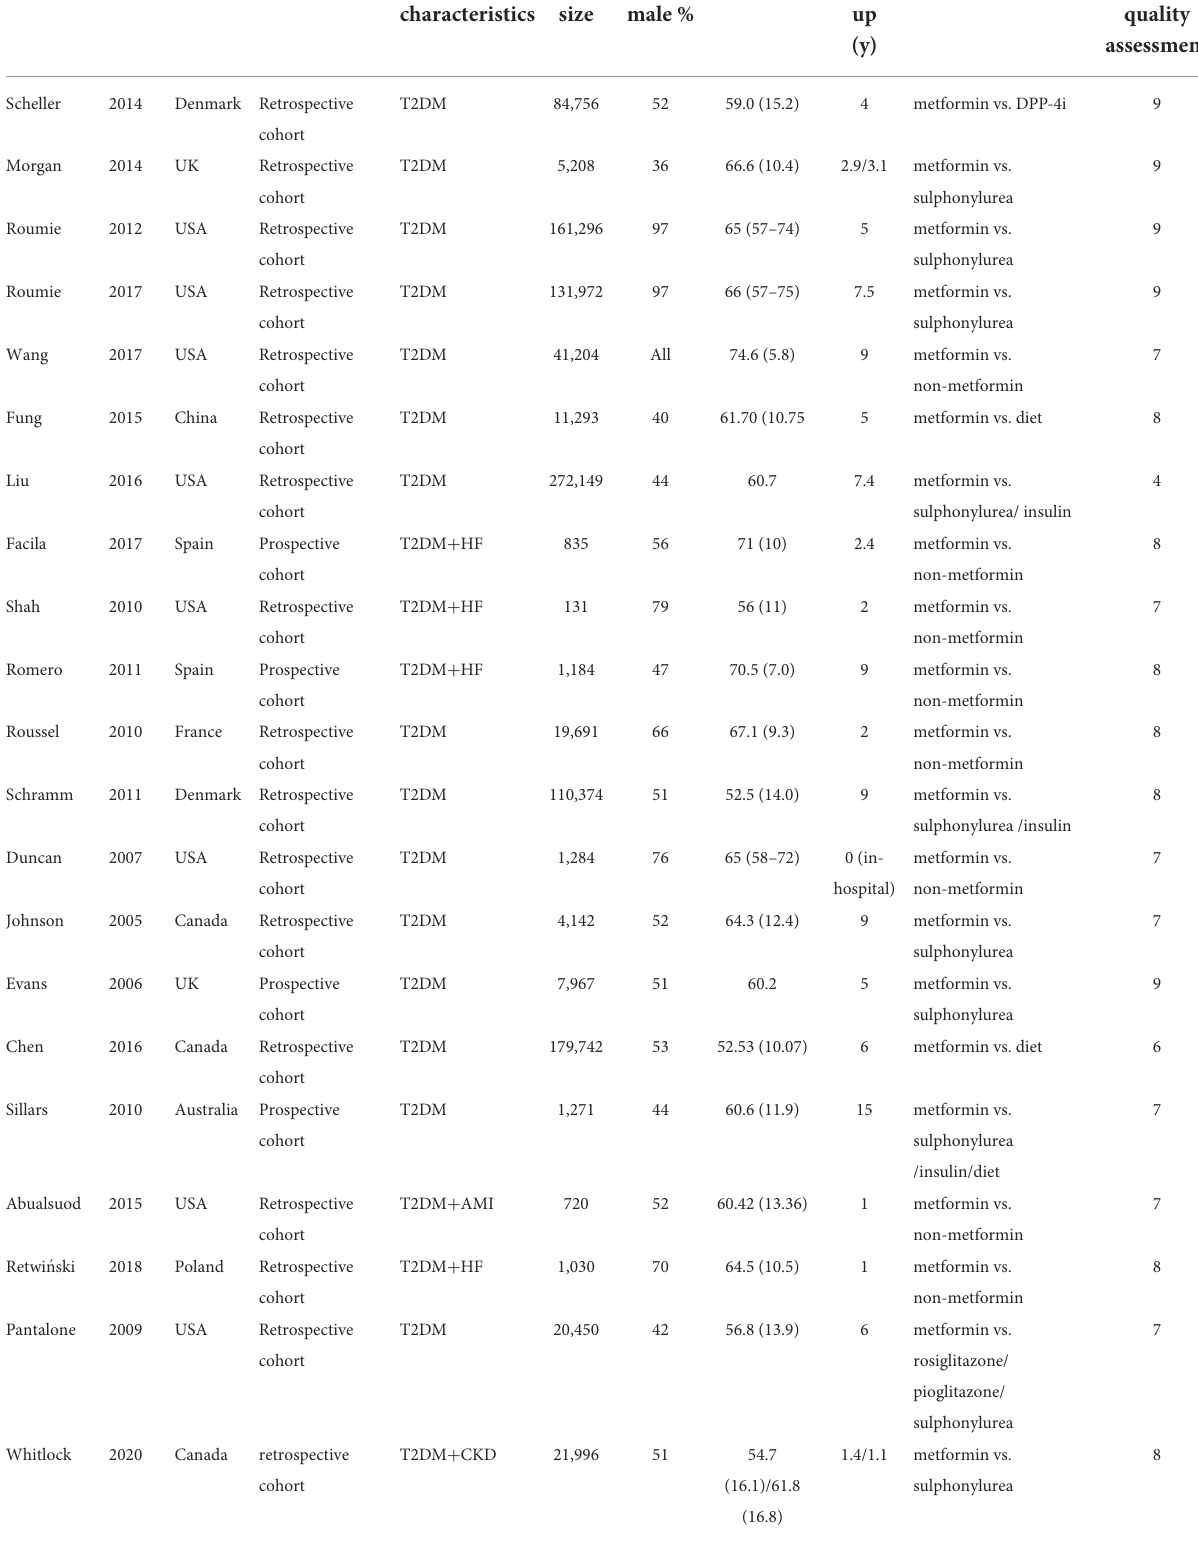
TABLE 1 Baseline characteristics of included